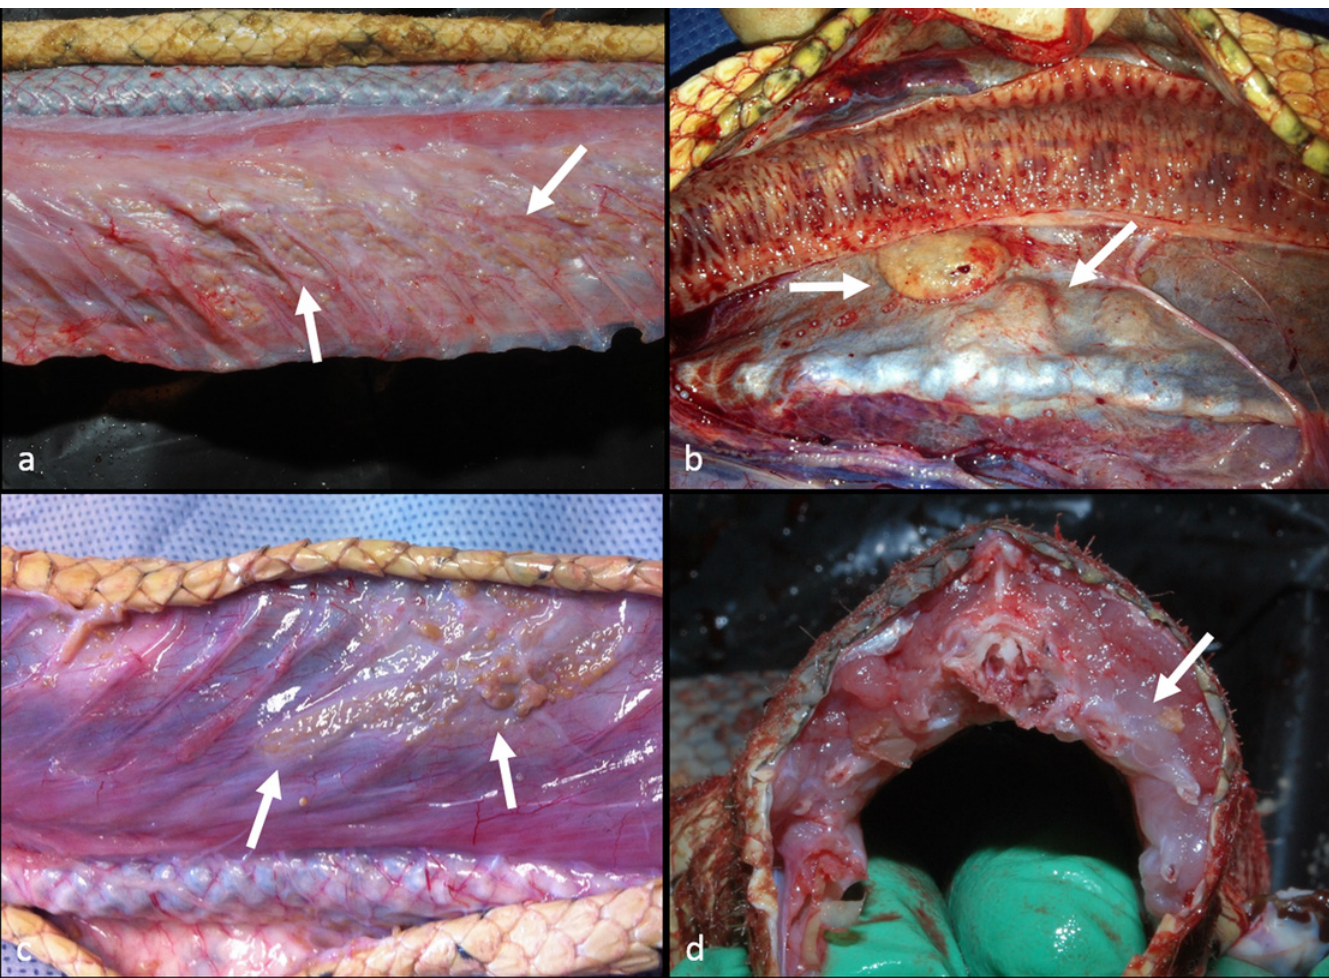
Fig 1. Gross appearance of axial muscles in hydrophiid sea snakes bearing numerous microsporidian granulomas. a) Multiple granulomas (arrows) containing microsporidian parasites associated with costal fractures in Hydrophis major (HM1). b) Multiple granulomas (arrows) in the hypaxial muscles adjacent to the spine in Hydrophis elegans (HE1). c) Multiple granulomas (arrows) visible in the intercostal muscles of Hydrophis major (HM2). d) Locally extensive regions of pallor (arrows) in the hypaxial and intercostal muscles of Hydrophis major